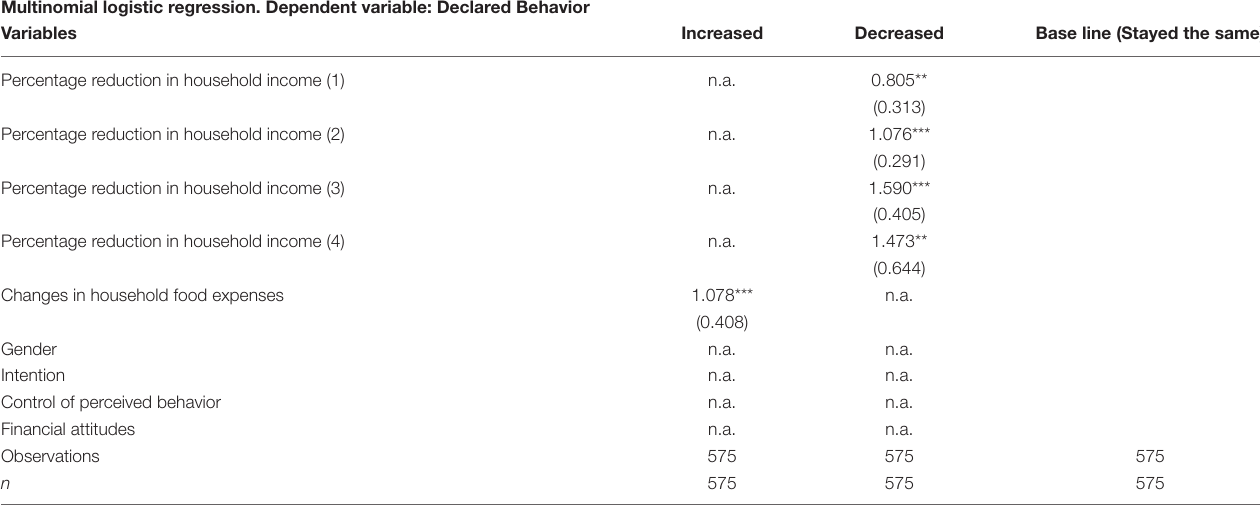
TABLE 8 | Multinomial logistic regression for the variable declared behavior . Multinomial logistic regression. Dependent variable: Declared